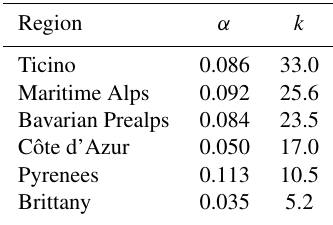
Table 1. Gamma distribution shape ( α ) and scale ( k ) parameter val- ues with respect to daily flash numbers in various regions. For better comparability, flash numbers have been spatially averaged over the single grid cell